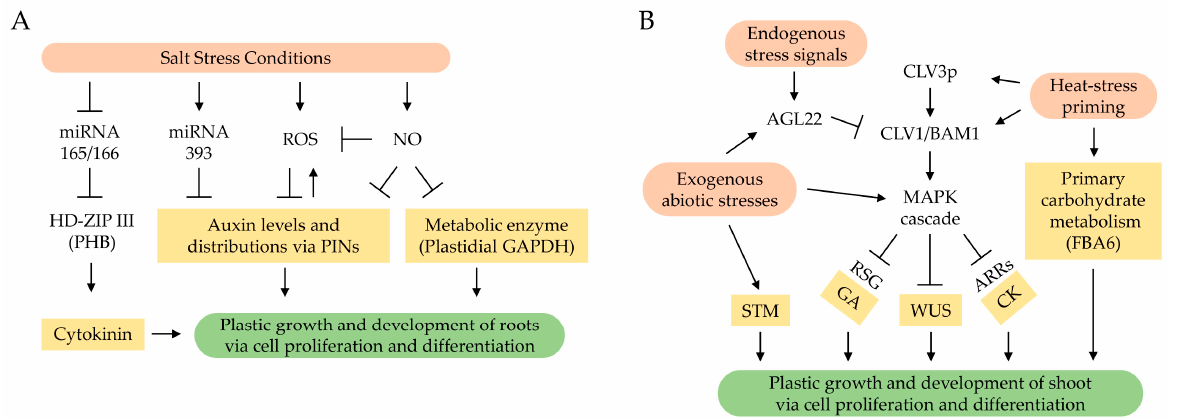
Figure 1. Hypothetical models of signaling networks for stress-mediated plant growth and development. ( A ) Salt stress conditions induce various endogenous signals, such as ROS, NO, and miRNAs, to regulate phytohormones, such as auxin and cytokinin, for controlling adaptive growth and development in root meristems. ( B ) Exogenous and endogenous signals affect various signaling network layers related to the CLV3–WUS pathway regulating stem cell homeostasis in shoot meristems. Author Contributions: H.L. designed the scheme of the manuscript. H.L. and S.Y. wrote the manu-